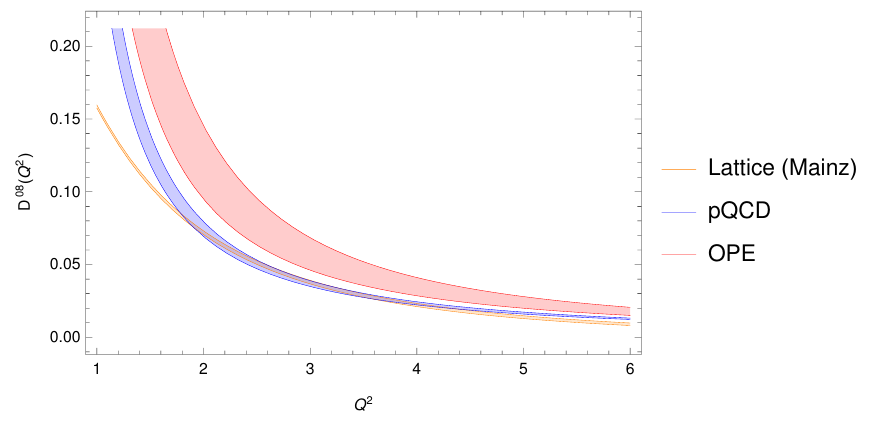
Figure 21 . Comparison between the Adler function D 08 ( Q 2 ) obtained from the lattice results of ref. [14] and the one from the OPE of the associated